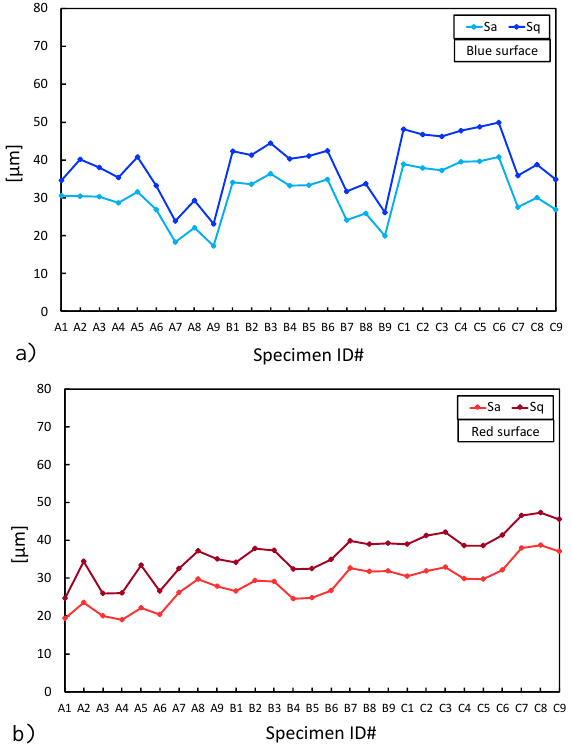
Figure 9. S a and S q comparison: ( a ) blue surface ( BS ); ( b ) red surface ( RS